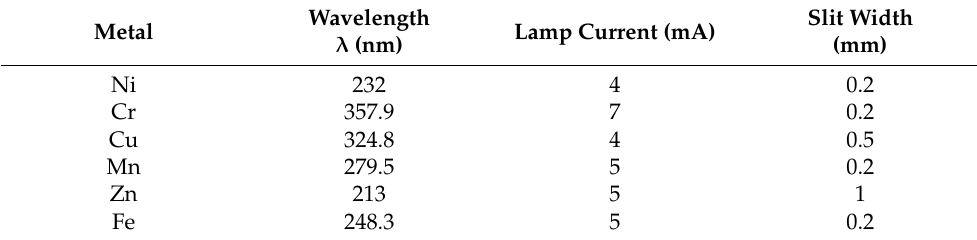
Table 1. Working conditions for Varian Spectra 240 FS